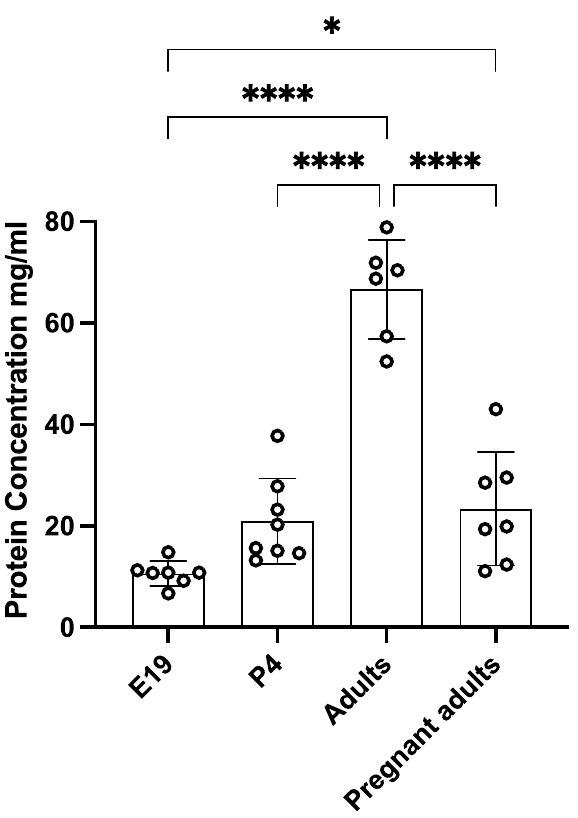
Figure 1. Plasma protein concentration. Total protein concentration in plasma (mg/ml) of E19, P4, non- pregnant and pregnant female adult rats measured using Bradford method. Each point represents an individual animal. Mean ± SD; n = 6–8. One-way ANOVA with Tukey’s multiple comparisons; * p < 0.05, **** p <